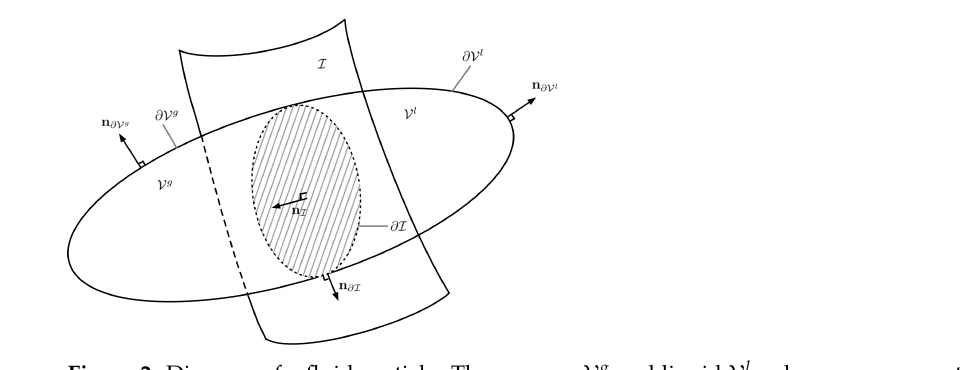
Figure 2. Diagram of a fluid particle. The gaseous V g and liquid V l volumes are separated by an interface I